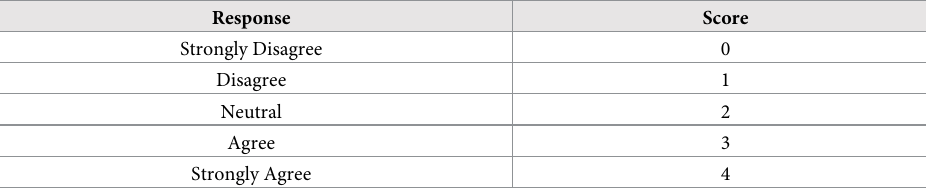
Table 7. Five points Likert scale for the collection of respondent response.